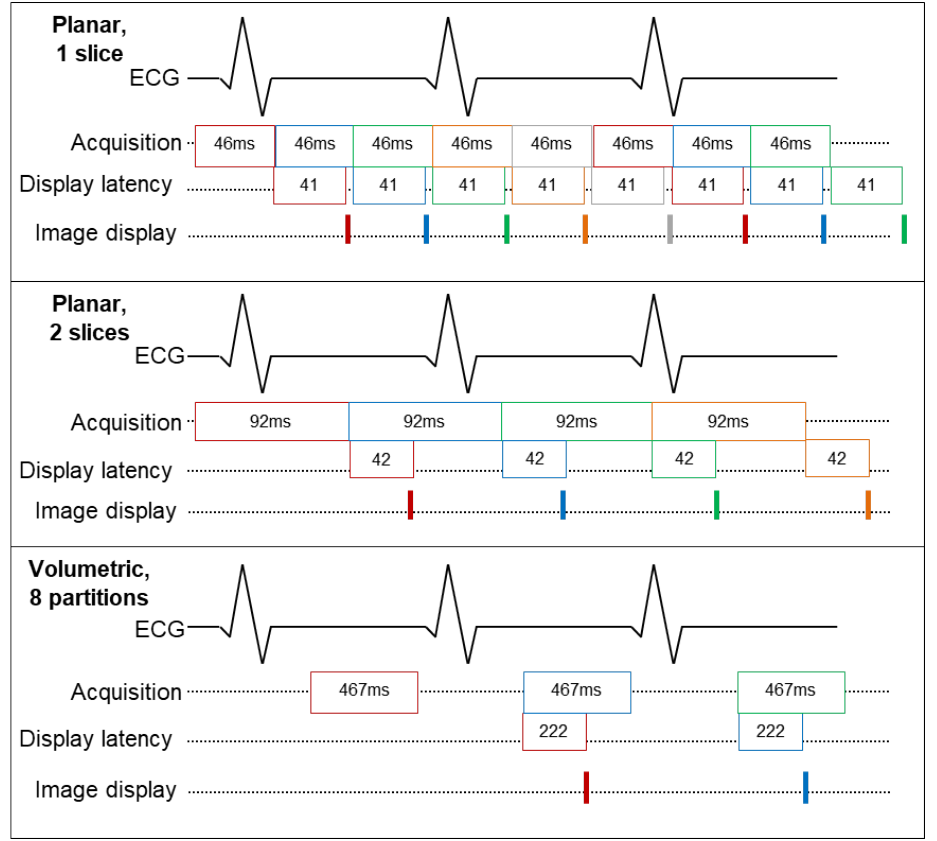
Figure 4. Schematic showing the time required for multiple frames of data to pass through the system for three different dataset types: ( top ) single-slice planar, ( middle ) two-slice planar, and ( bottom ) eight-partition volumetric. Planar data are acquired continuously, while volumetric data are ECG-gated. Images are displayed to the user before completing acquisition of the following frame for all cases. Different colors represent different frames.